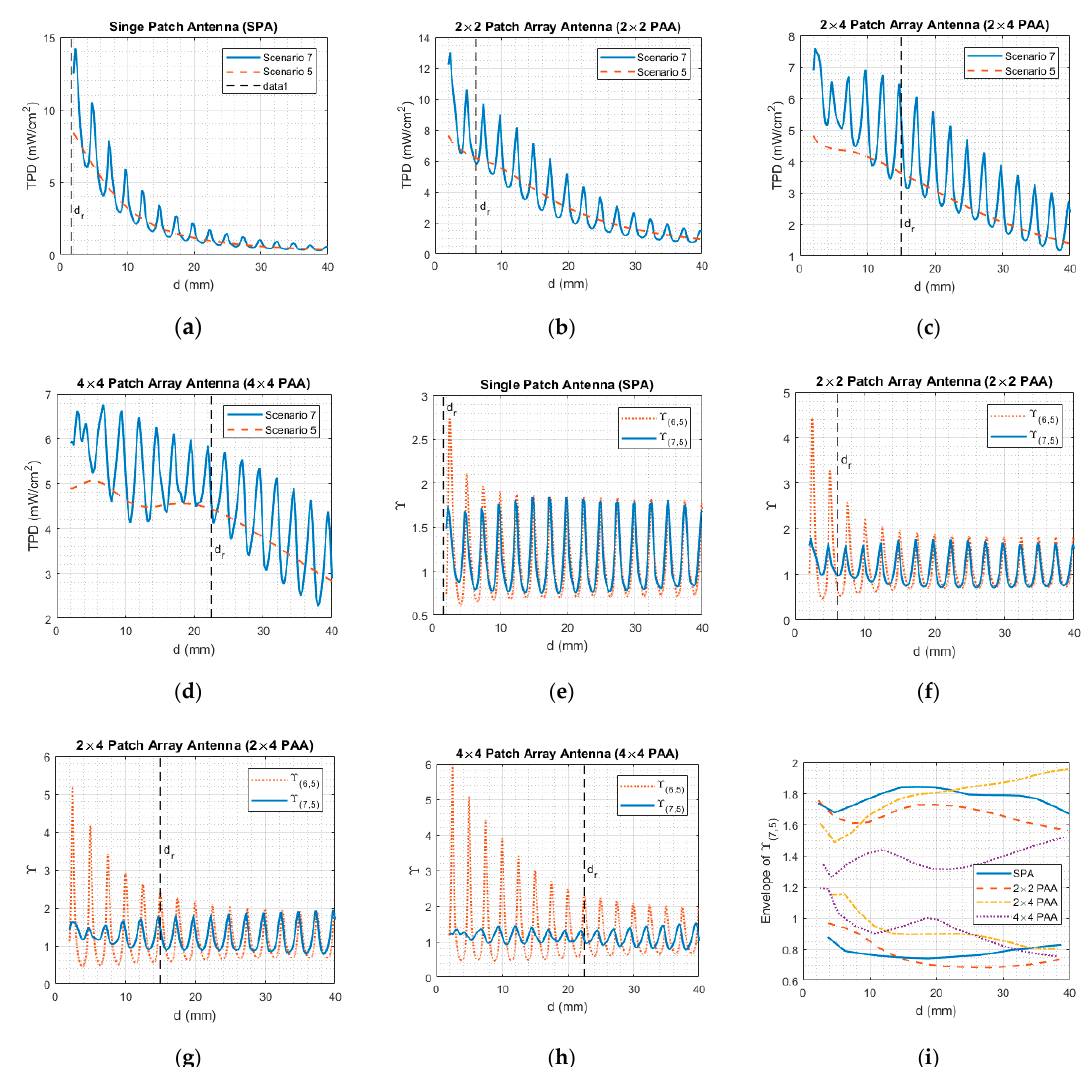
Figure 10. Patch antenna arrays and their corresponding equivalent sources (scenarios 5 and 7). Peak TPD of ( a ) SPA; ( b ) 2 × 2 PAA; ( c ) 2 × 4 PAA; ( d ) 4 × 4 PAA. TPD variations due to antenna/phantom coupling: ( e ) SPA; ( f ) 2 × 2 PAA; ( g ) 2 × 4 PAA; ( h ) 4 × 4 PAA. The interface between the reactive and radiating near-field regions are denoted with d r = 0.62 D 3 / λ , where λ 0 is the free-space wavelength and D is the largest dimension of the patch array elements [30]. ( i ) Envelope of Υ ( 7,5 )